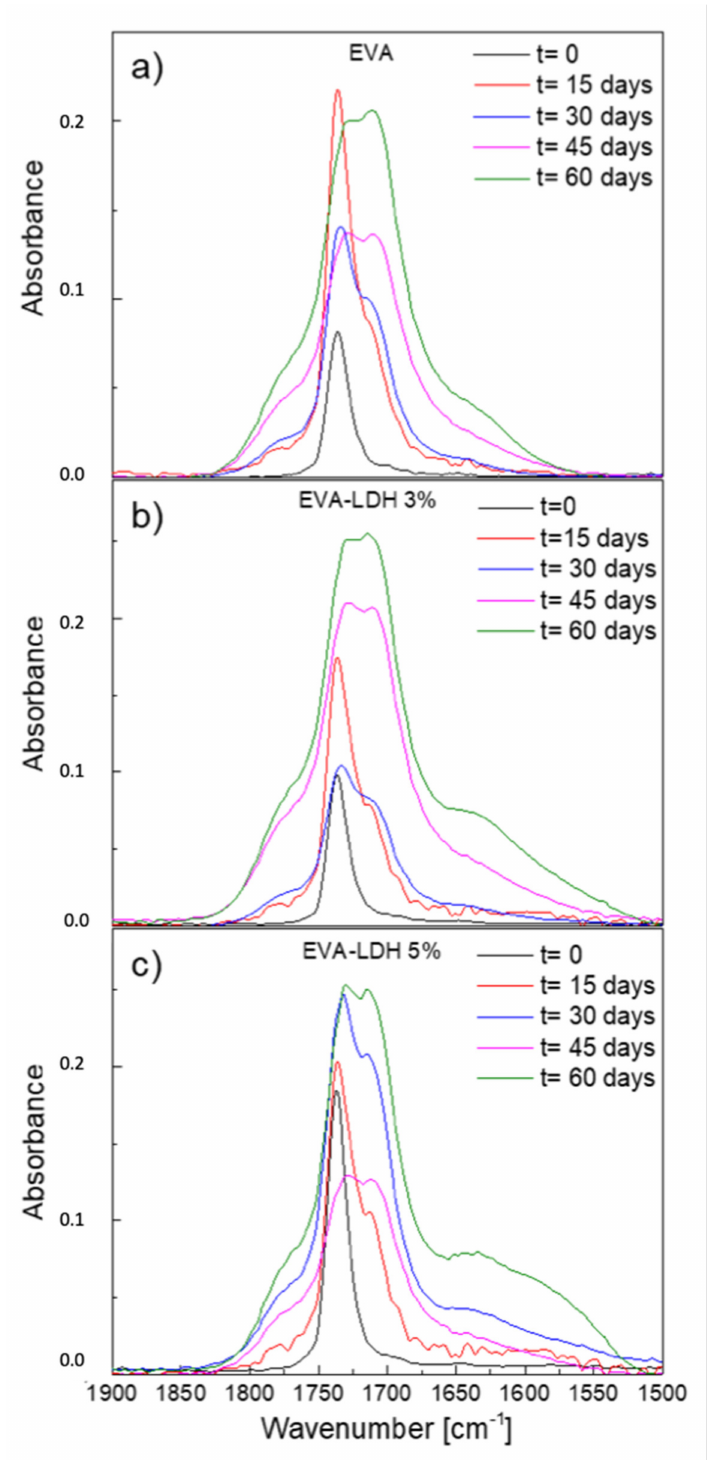
Figure 3. FT-IR spectra in the carbonyl region for EVA ( a ), EVA-LDH 3% ( b ) and EVA-LDH 5% ( c ) samples at different exposure